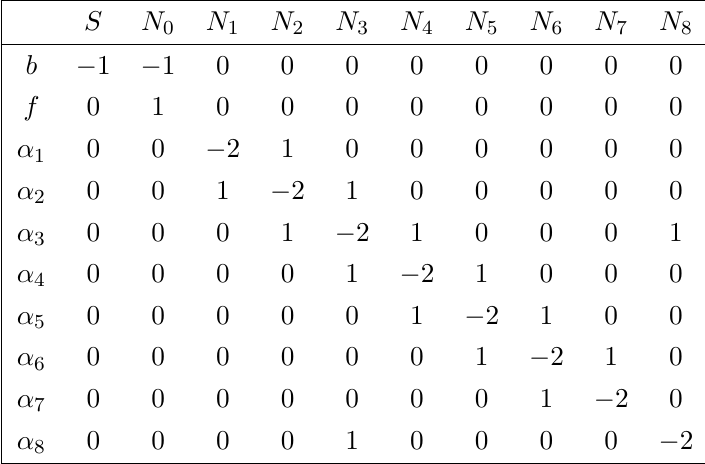
Table 7 . The full curve-surface intersection matrix of the E-string